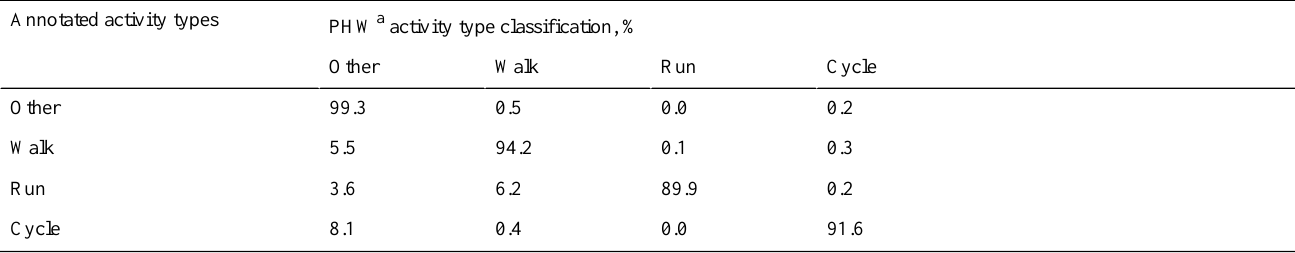
Table 7. A confusion matrix denoting the percentages of correct and incorrect activity type classifications compared with reference annotated activity types.